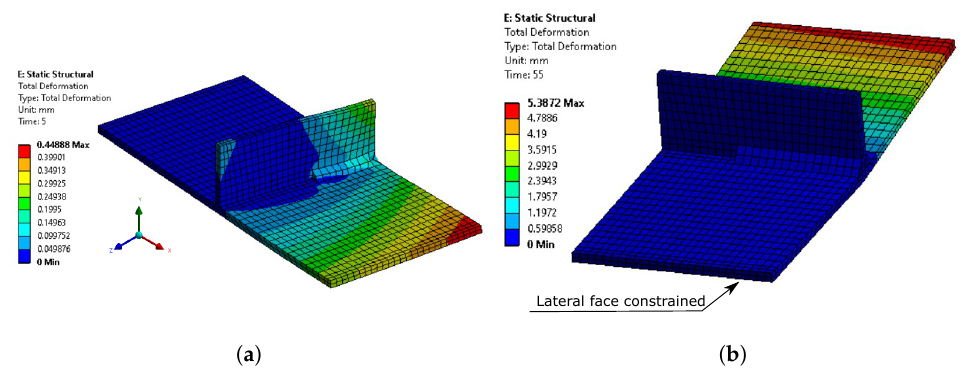
Figure 11. Vertical deformation contours for the Bhatti model at ( a ) 5 s (41 scale factors) and ( b ) 55 s (3 scale factors), as well as the boundary conditions.